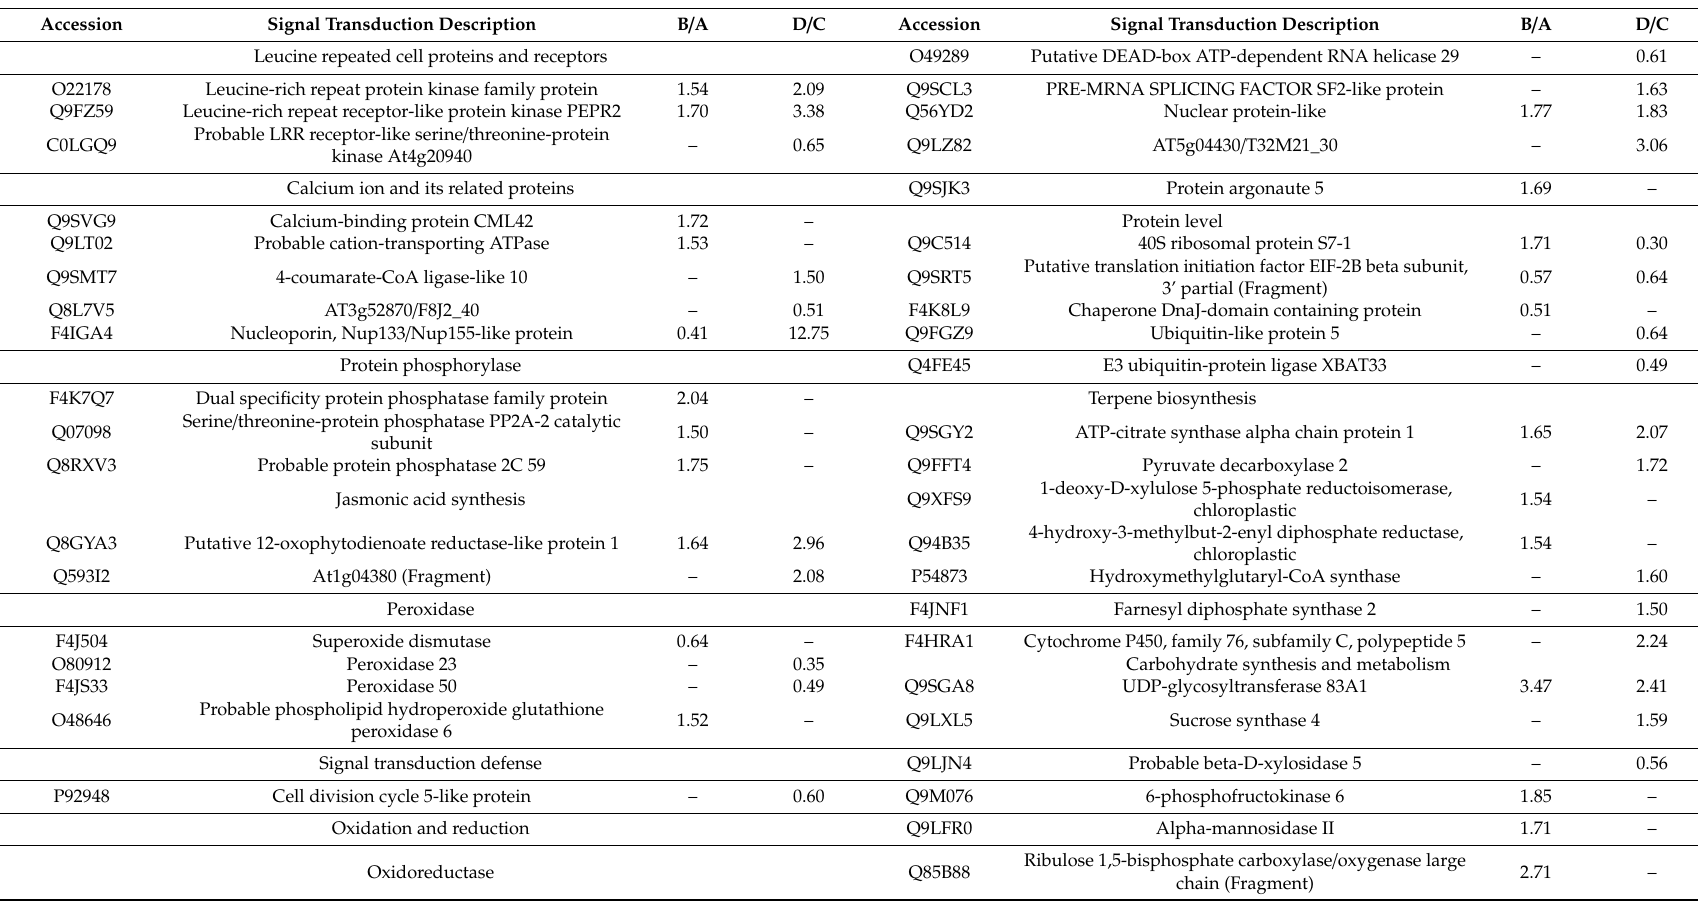
Table 3. The di ff erential proteins of S. miltiorrhiza hairy roots after PSF treatment on third day and sixth